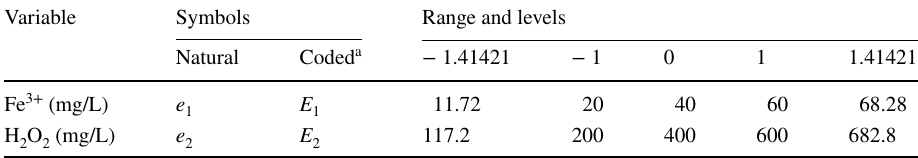
Table 1 Range and levels of natural and corresponded coded variables for CCD